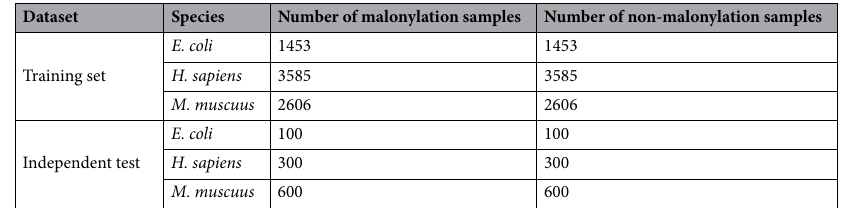
Table 1. The number of malonylation and non-malonylation samples in the